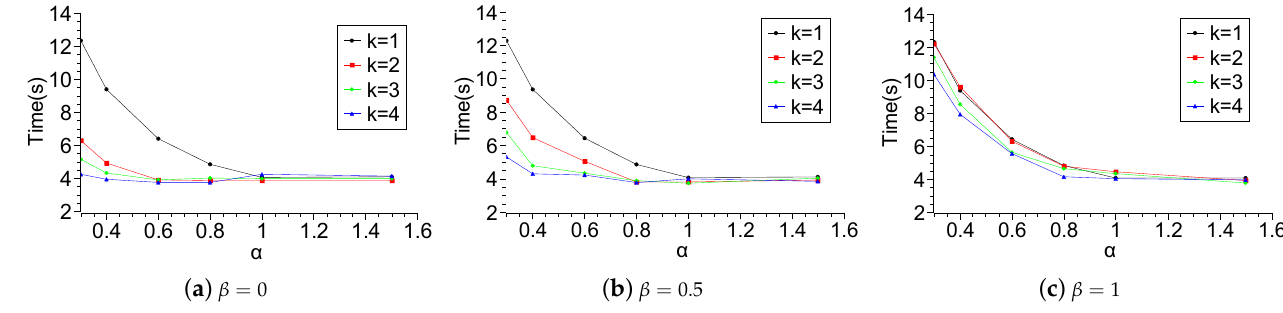
Figure 6. Relation of Data Transfer Completion Time with α and k when β = 0, 0.5, 1. ( a ) The variation trends of data transfer completion time when β = 0. ( b ) The variation trends of data transfer completion time when β = 0.5. ( c ) The variation trends of data transfer completion time when β =